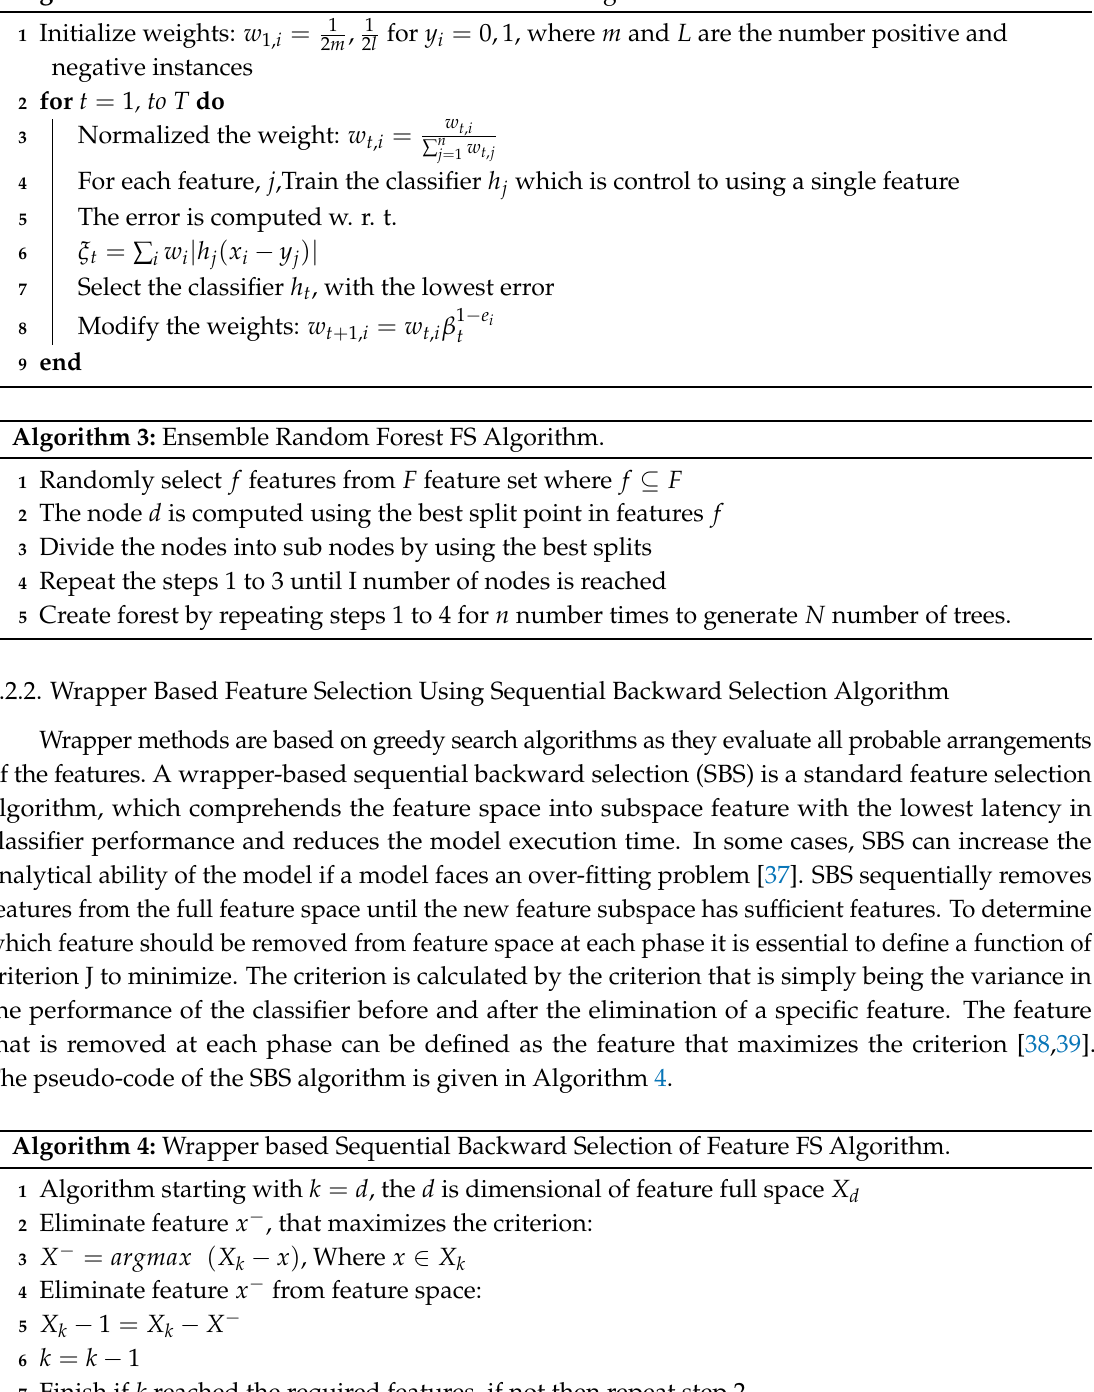
Algorithm 2: Ensemble Decision Tree Ada Boost FS algorithm.